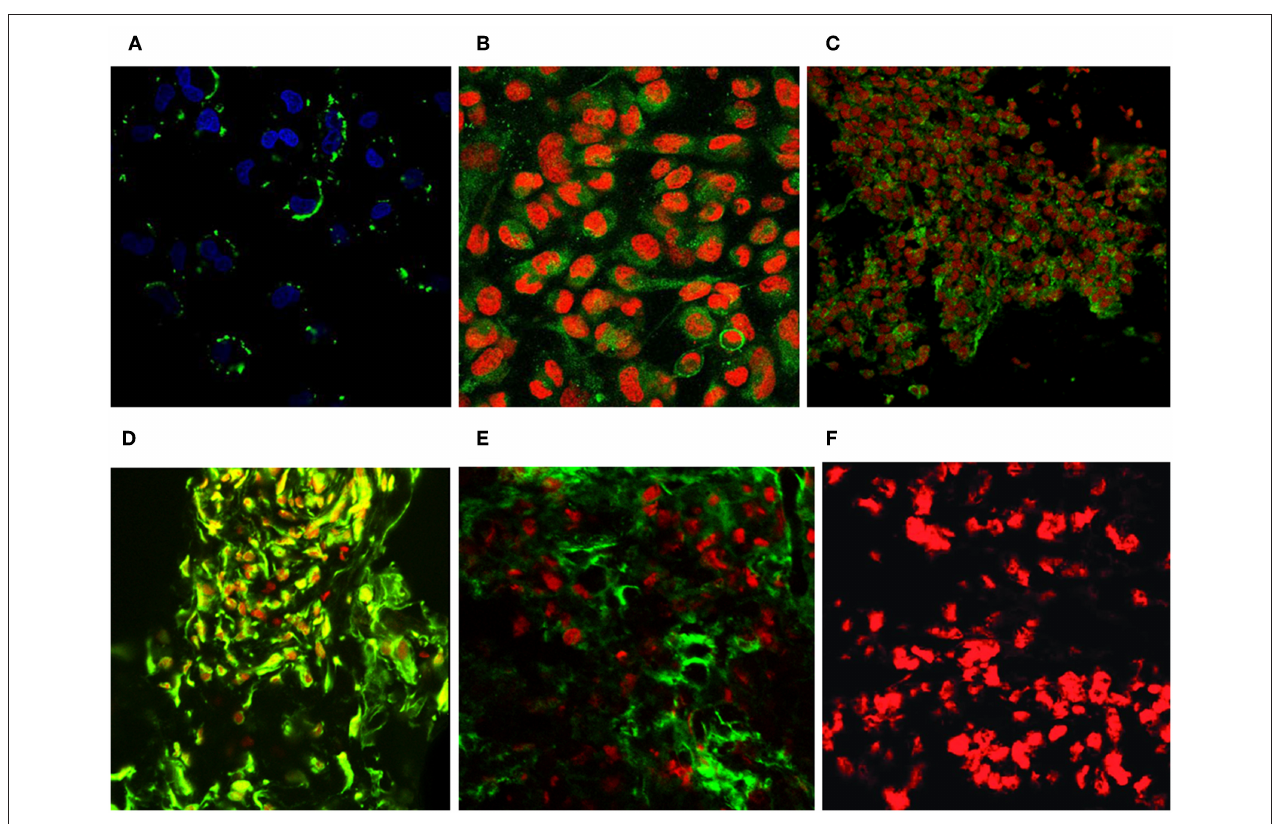
FIGURE 9 | Revealing GD3 ganglioside expression on cultured melanoma cells and fresh frozen cancerous melanoma tissues. Unique GD3 ganglioside expression could be detected in chamber slide cultured melanoma cells [SK MEL28, M24, A2058 with the selected scFvK antibody fragment (A–C) ]. (C) is reproduced with permission from (22). Fresh frozen melanoma tissue cryostat sections evidenced as well the positive reaction with our selected scFvK antibody fragment (D) . Commercially available antiGD3 ganglioside antibodies were also tested (E) on melanoma tissue sections and compared to the negative control (F) . FITC labeled anti-mouse IgG (Fab’)2 and Anti-E Tag antibodies were used with propidium iodide or DAPI nucleus staining. The extinction and emission laser parameters for FITC detection were 488 and 520nm, while for the propidium iodide they were 534 and 610nm, respectively (200x,